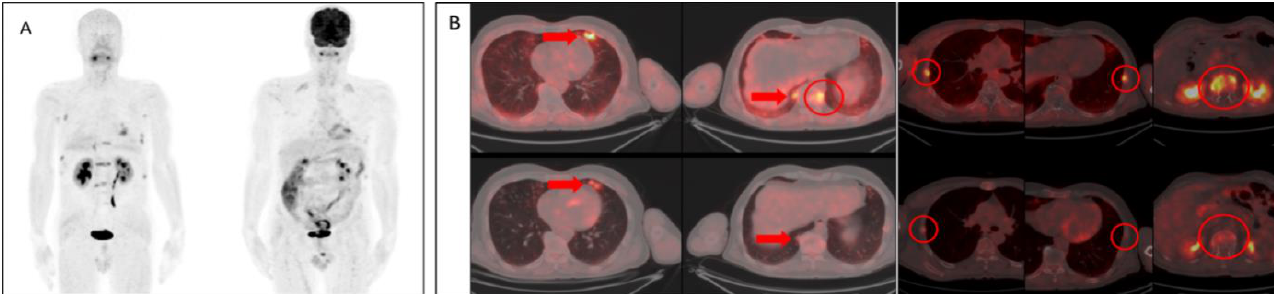
Figure 1. Patient No 1. 58 year-old-male diagnosed with MM. ( A ) Visual comparison of maximum intensity projections of both modalities (Left [68Ga]FAPI, right [18F]FDG) showed superior image quality and higher specific activity retentions with [68Ga]FAPI PET/CT. ( B ) In axial plane evaluations, both imaging methods demonstrated extramedullary involvement of MM in the lungs (Arrows); however, SUV max values of the lesions were noted to be higher in [68Ga]FAPI PET/CT (Upper row). Also, significantly higher activity uptake was observed in the bone lesions (Circles) with [68Ga]FAPI (Upper row) when compared to [18F]FDG (Lower row).